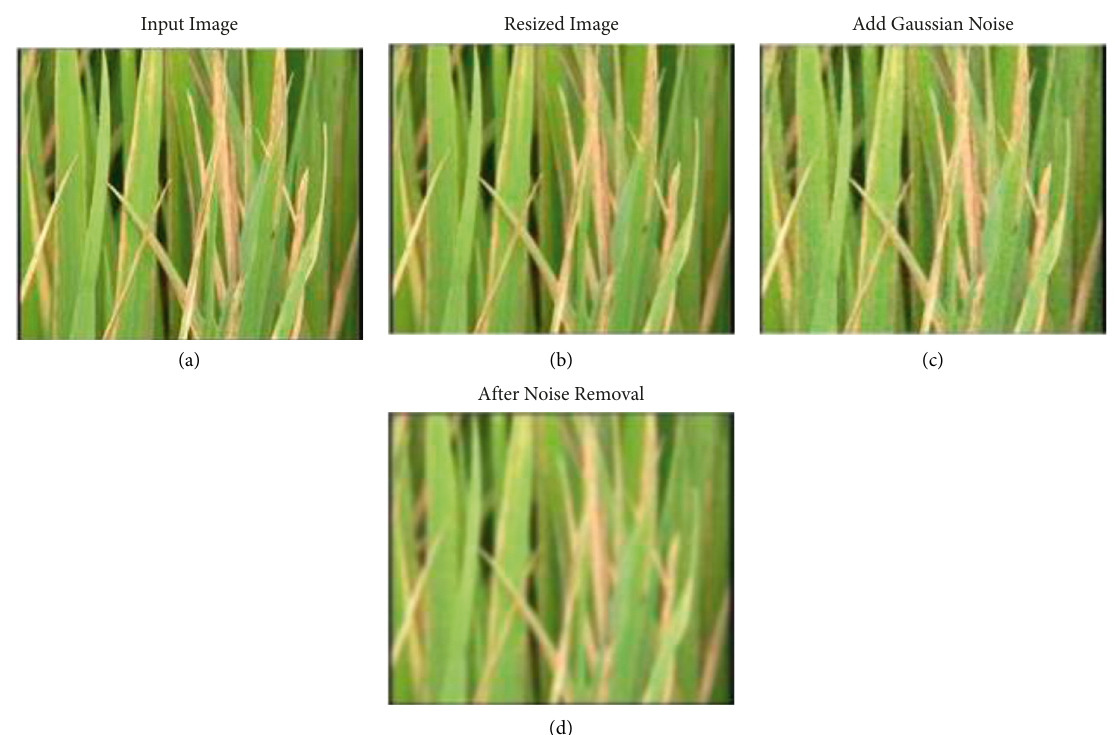
Figure 7: Results of Gaussian noise. (a) Original image of bacterial leaf blight. (b) Resized image. (c) Denoised image. (d) Image obtained after denoised using the Gaussian filter.